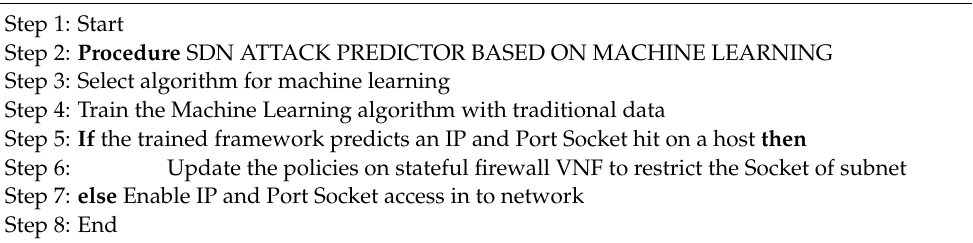
Algorithm 1 Predictor for SDN network attacks modelled on machine